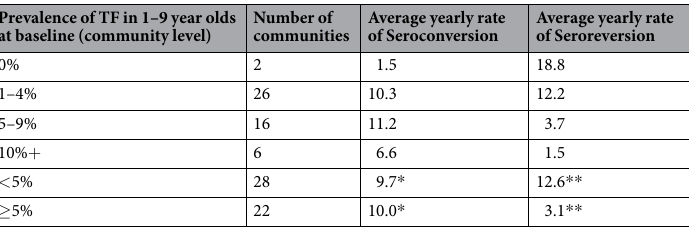
Table 6. Community level prevalence of follicular trachoma in 1–9 year olds, and average rates of seroconversion and seroreversion. * t-test p = 0.92, ** t-test p =